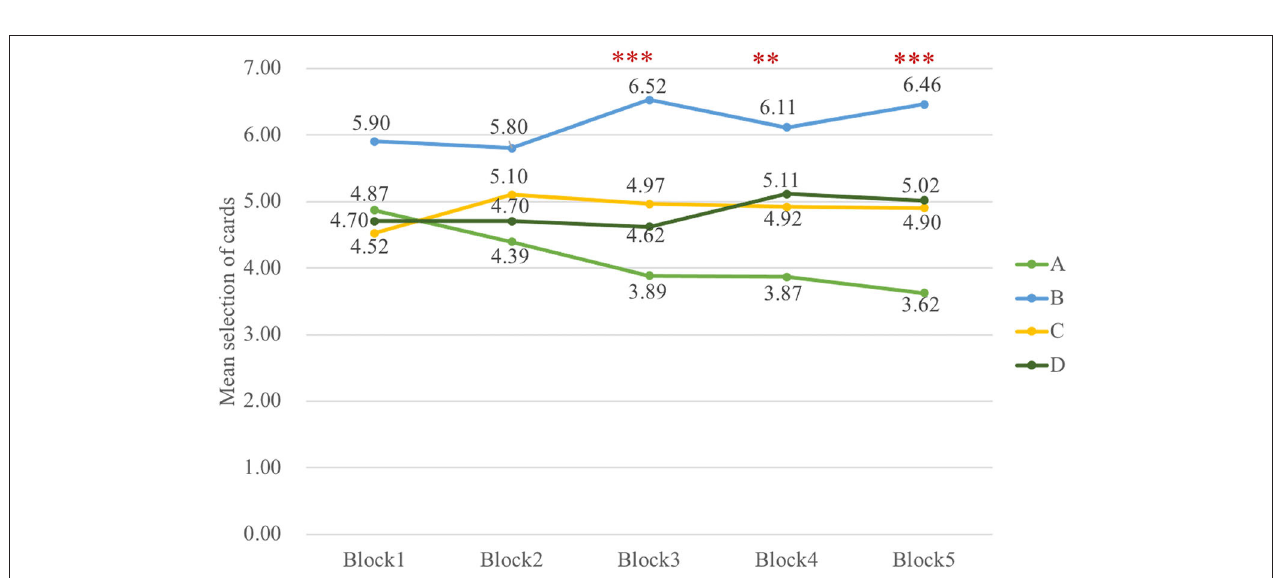
FIGURE 3 | The selective pattern of control. Blue bars represent the four-deck format of the control group, and the number of selections from deck B is significantly larger than the other three decks. ** p < 0.01, *** p < 0.001.